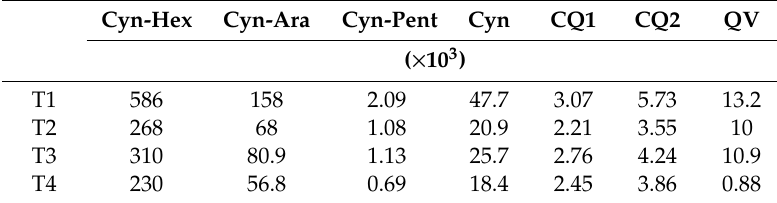
Table 2. Relative composition of phenolic compounds in four A. melanocarpa extracts (T1~T4) as determined by LC/MS.